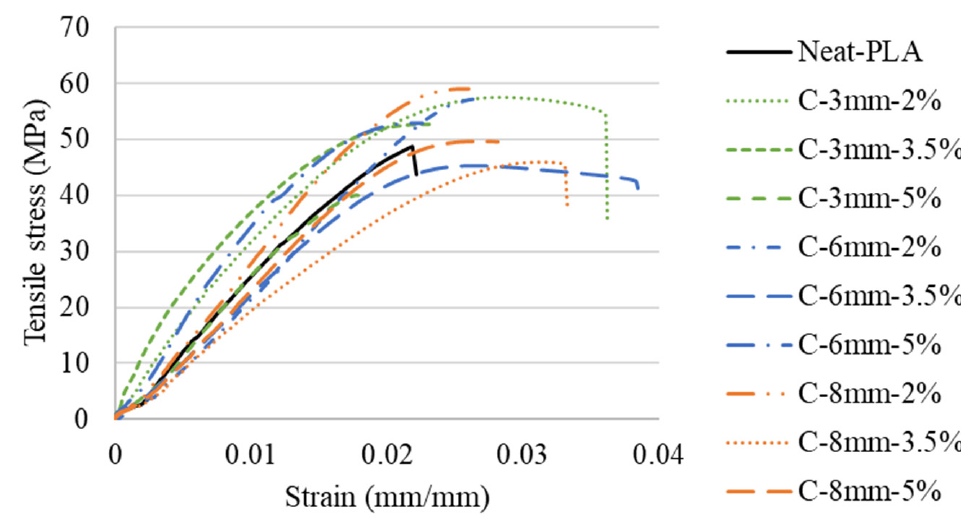
Figure 6. Representative tensile stress–strain curves.